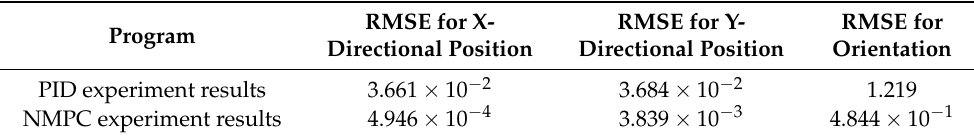
Table 1. Comparison of the RMSE of PID experiment and NMPC experiment.